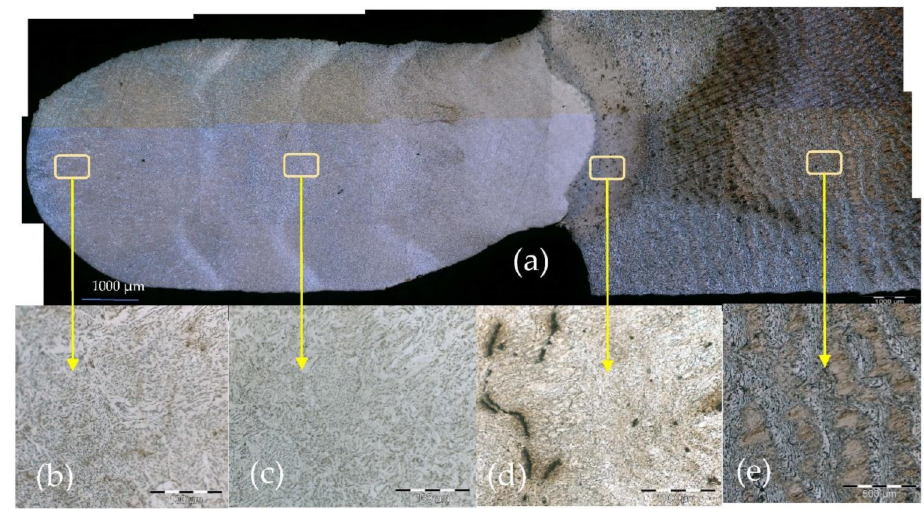
Figure 7. ( a ) Microstructure of printed (WAAM) sample alloy ER70S-6/S235JR obtained by optical microscopy; ( b ) microstructure of the sixth layer; ( c ) microstructure of interstitial 3rd–4th layer;